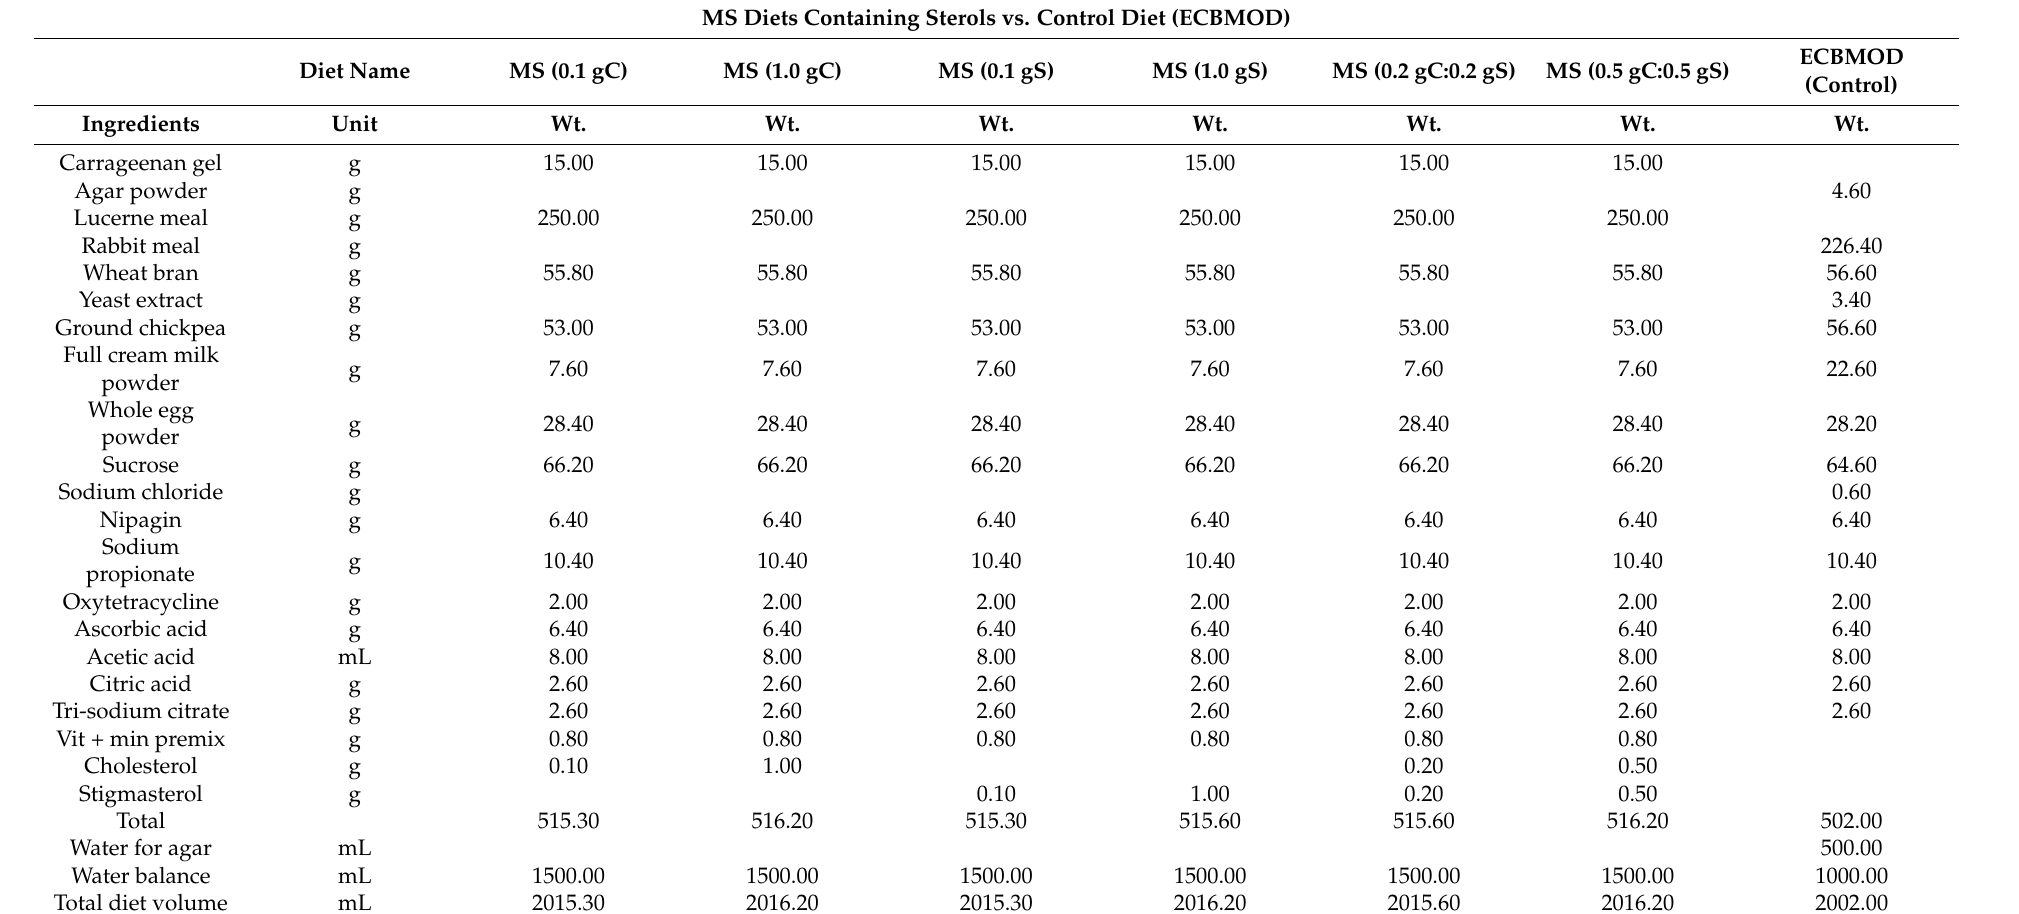
Table 1. Eldana saccharina MS diet with incorporation of different sterol components and ECBMOD control diet